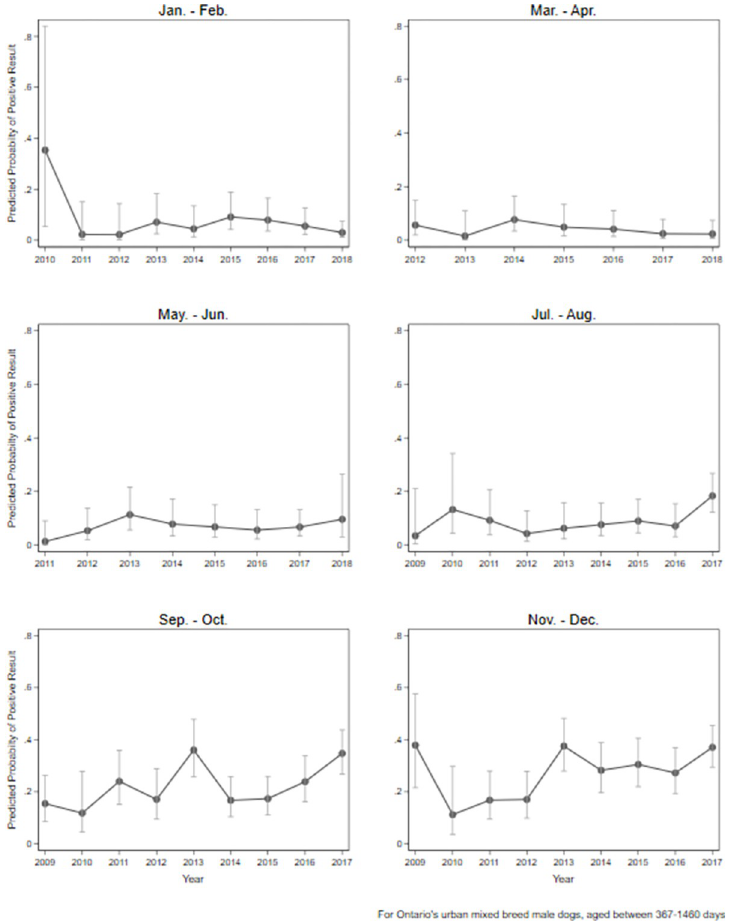
Fig 6. Margin plots of predicted probability ( ± 95% CI) of PCR-positive Leptospira test result in dogs by month and year of testing, Canada. Predicted probabilities based on an urban, mixed breed, 1–4-year-old dog tested in Ontario,